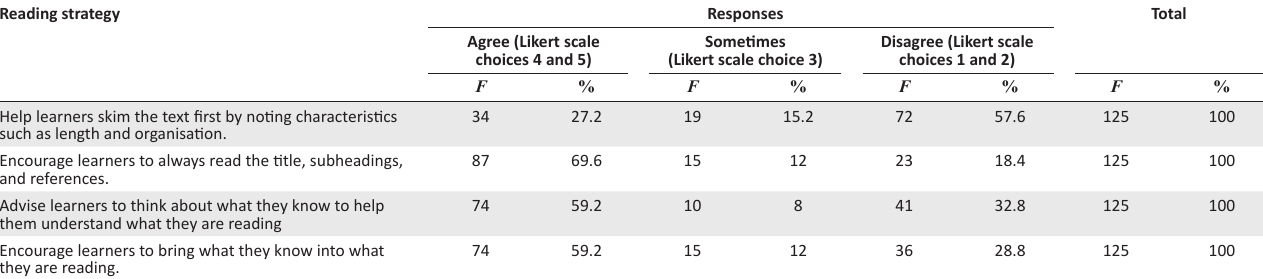
TABLE 1: Pre-reading or before-reading strategies. Reading